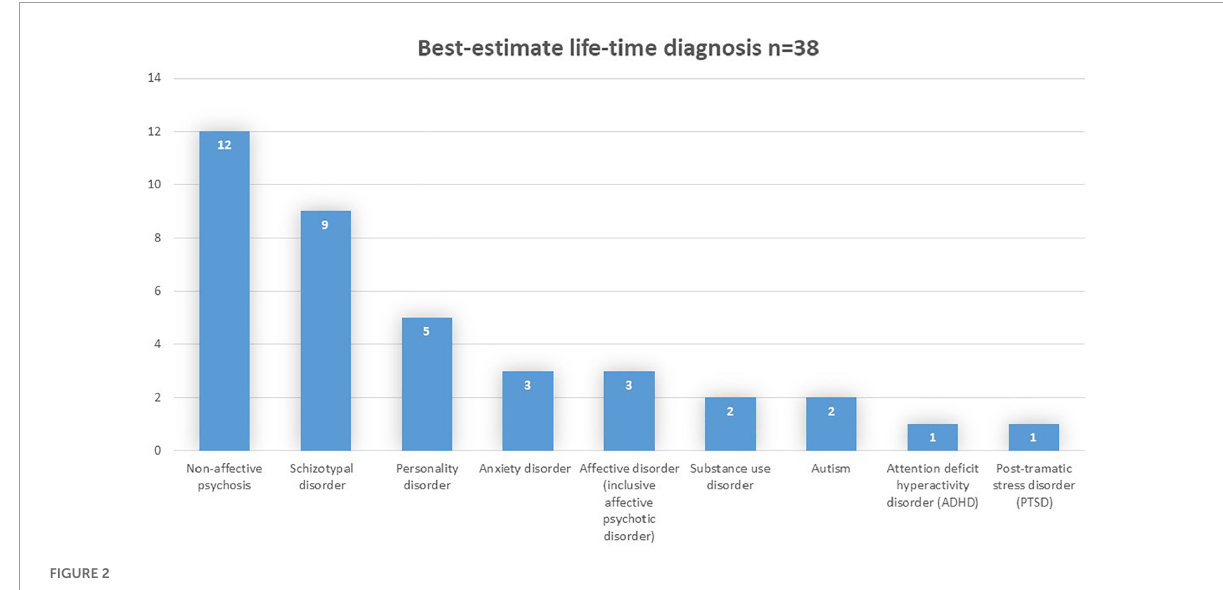
FIGURE2 Distribution of mental disorders.